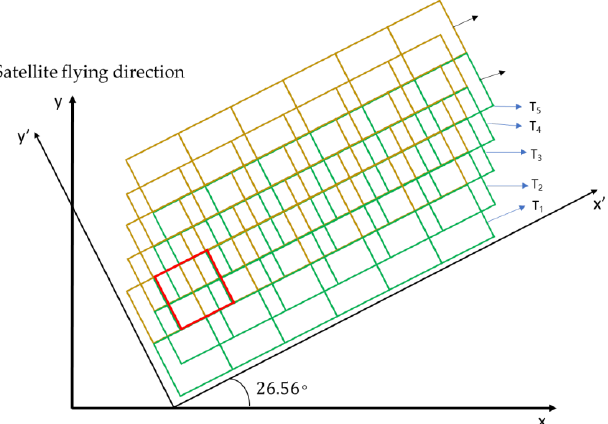
(cid:17) ◦ (cid:16) arctan 1 oblique sampling ) oblique sampling mode. Figure 5. The diagram of 2 rows 26.56 2 2